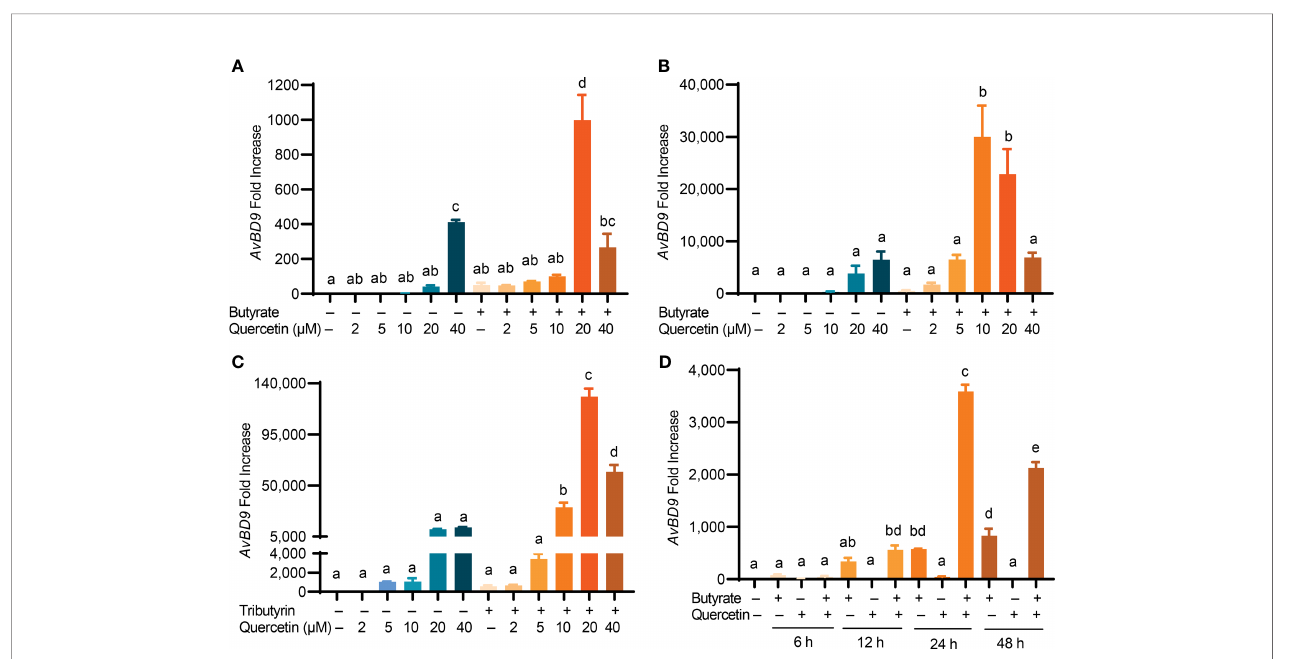
FIGURE 2 | Synergistic induction of AvBD9 gene expression by a combination of quercetin and butyrate or tributyrin. (A) Chicken HTC macrophages or (B) peripheral blood mononuclear cells (PBMCs) were treated in duplicate with indicated concentrations of quercetin with or without 2 mM butyrate for 24 h. (C) Chicken PBMCs were stimulated with indicated concentrations of quercetin with or without 0.25 mM tributyrin for 24 h. (D) Chicken PBMCs were treated in duplicate with 2 mM butyrate and 10 m M quercetin individually or in combination for indicated times. The expression levels of the AvBD9 gene were analyzed by RT-qPCR. Results are presented as means ± SEM of 2 – 3 independent experiments. The bars not sharing common superscript letters are signi fi cantly different ( P < 0.05) as determined by one-way ANOVA and post hoc Tukey ’ s test.